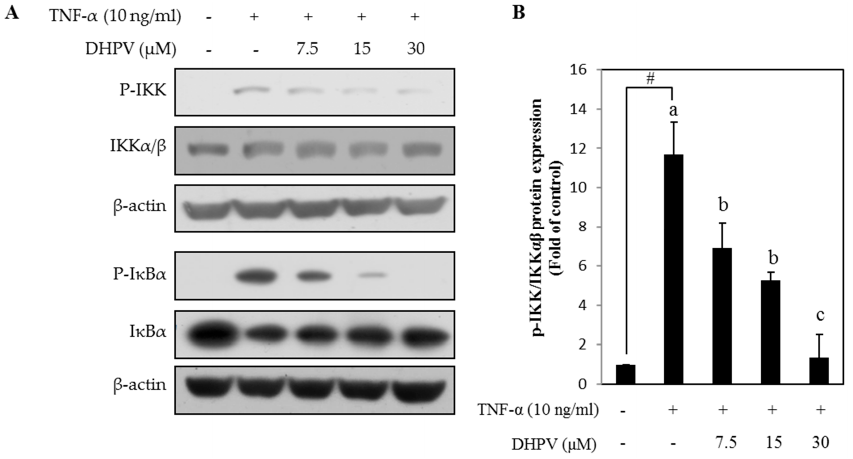
Figure 6. Effect of DHPV on TNF- α -stimulated NF- κ B signaling. Expression of phosphorylated and unphosphorylated proteins comprising the NF- κ B signaling pathway as determined by Western blot. ( A ) Representative image. ( B ) Quantification data of phosphorylated I kappa-B kinase (IKK), the upstream signaling protein of I κ B α . Data are expressed as means ± SD ( n = 3). # p < 0.05 versus control. Different letters denote significant differences ( p < 0.05); values bearing the same letters are not significantly different from each